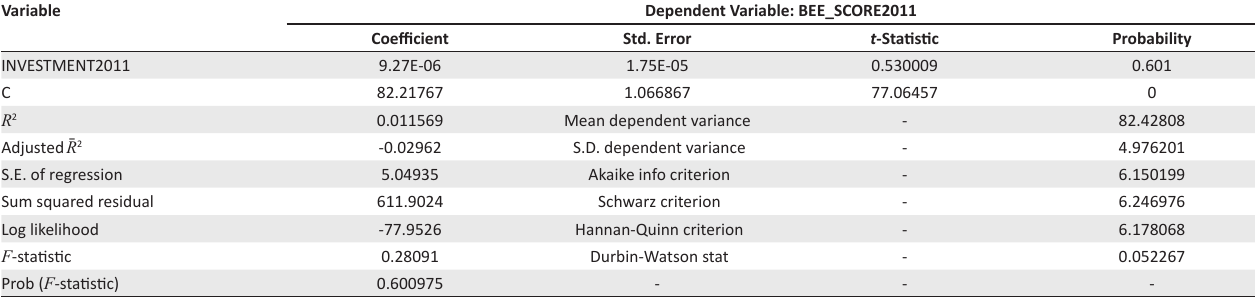
TABLE 4: Black economic empowerment and Investment.